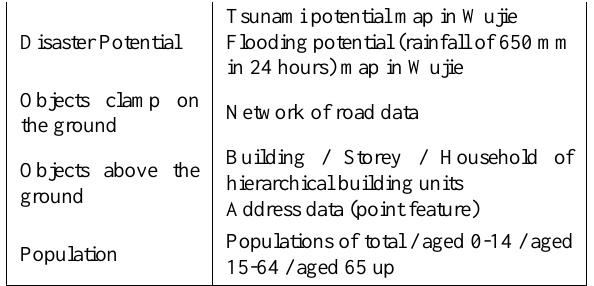
Table 3. Datasets used in this study